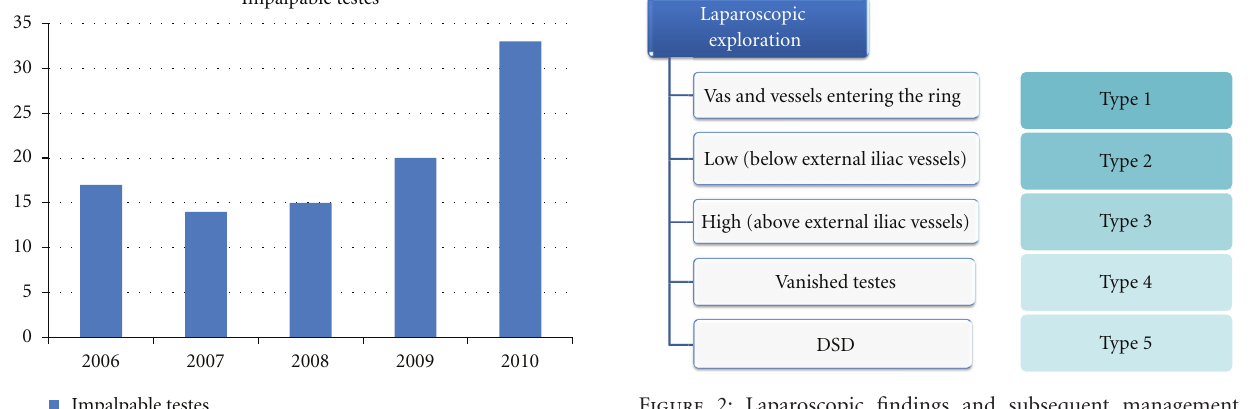
Figure 2: Laparoscopic findings and subsequent management of patients with undescended testes. DSD: disorders of sexual di ff erentiation.